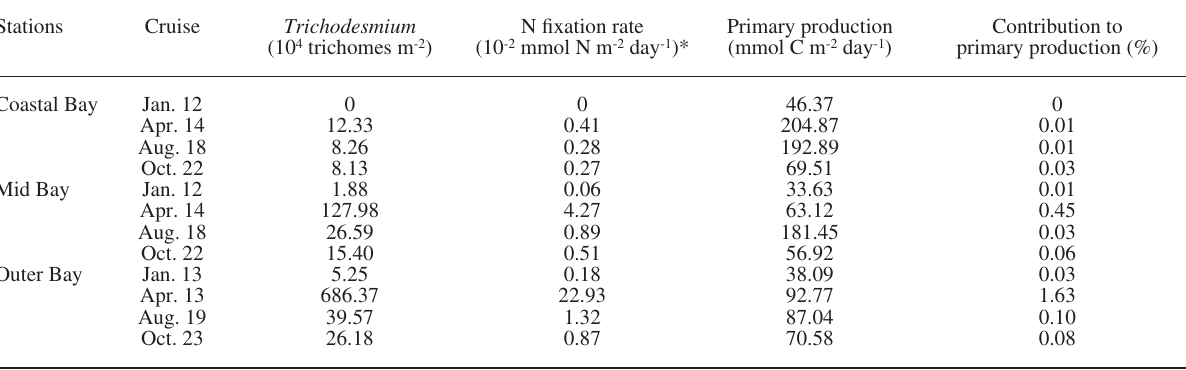
Table 4. – estimated Trichodesmium nitrogen fixation rate and its contribution to primary production in sanya Bay.